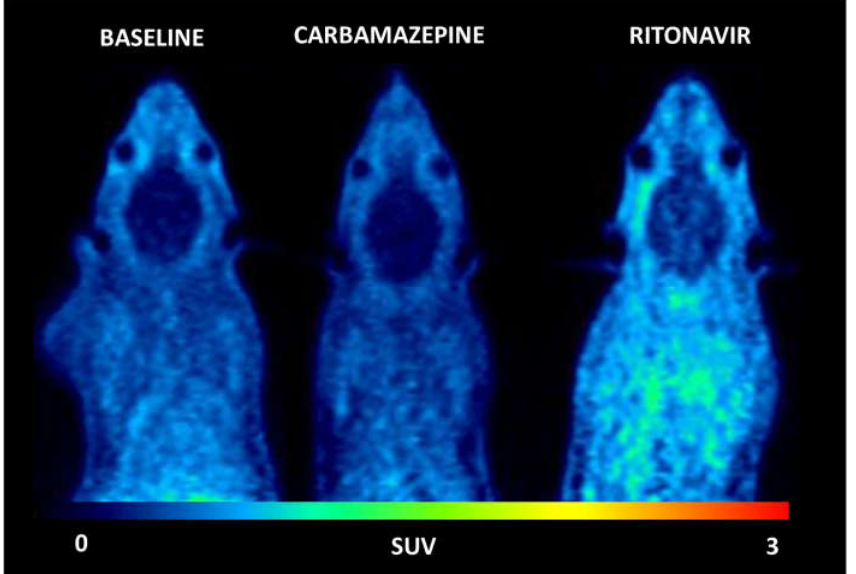
Figure 1. Representative PET summation images (from 0 to 30 min) of [ 11 C]metoclopramide from one baseline rat and one rat pretreated with carbamazepine (45 mg/kg twice a day for 7 days before PET) or ritonavir (20 mg/kg, 3 h before PET).